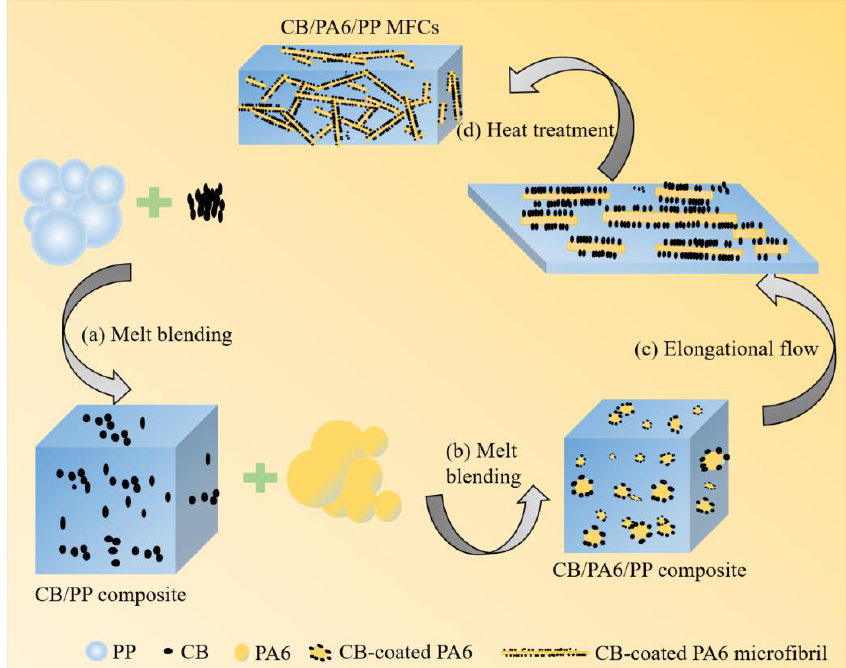
Figure 4. The formation diagram of the conductive network of the CB/PA6/PP microfibrillar com- posites (MFCs), ( a ) Melt bending; ( b ) Melt bending; ( c ) Elongational flow; ( d ) Heat treatment.